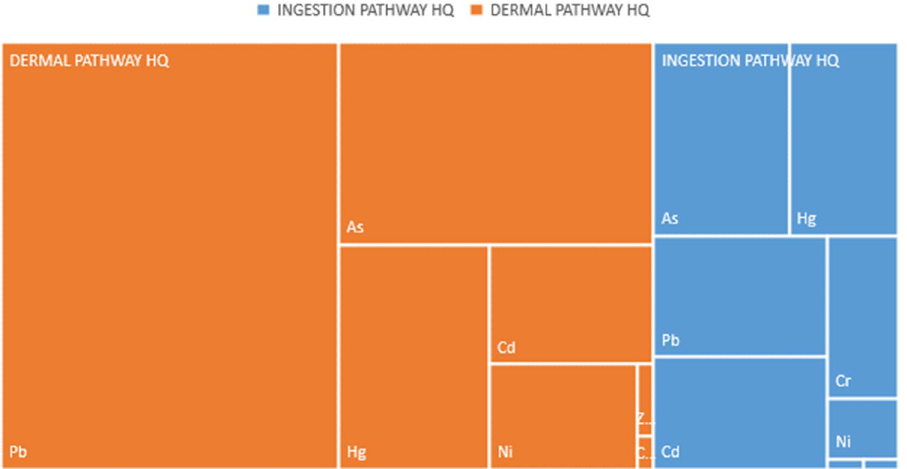
Figure 6. Hierarchical representation of the Ingestion and Dermal Pathways Hazard Quotient.